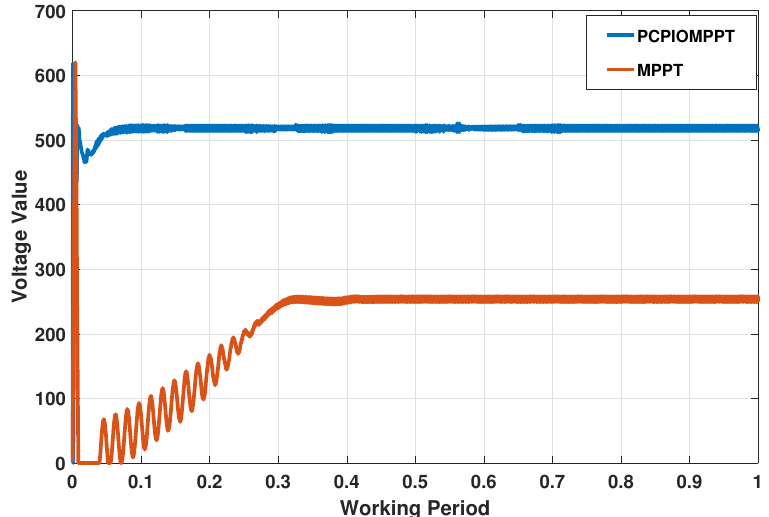
Figure 11. Maximum power curve of photovoltaic power generation under the control of MPPT algorithm and PCPIO and MPPT hybrid